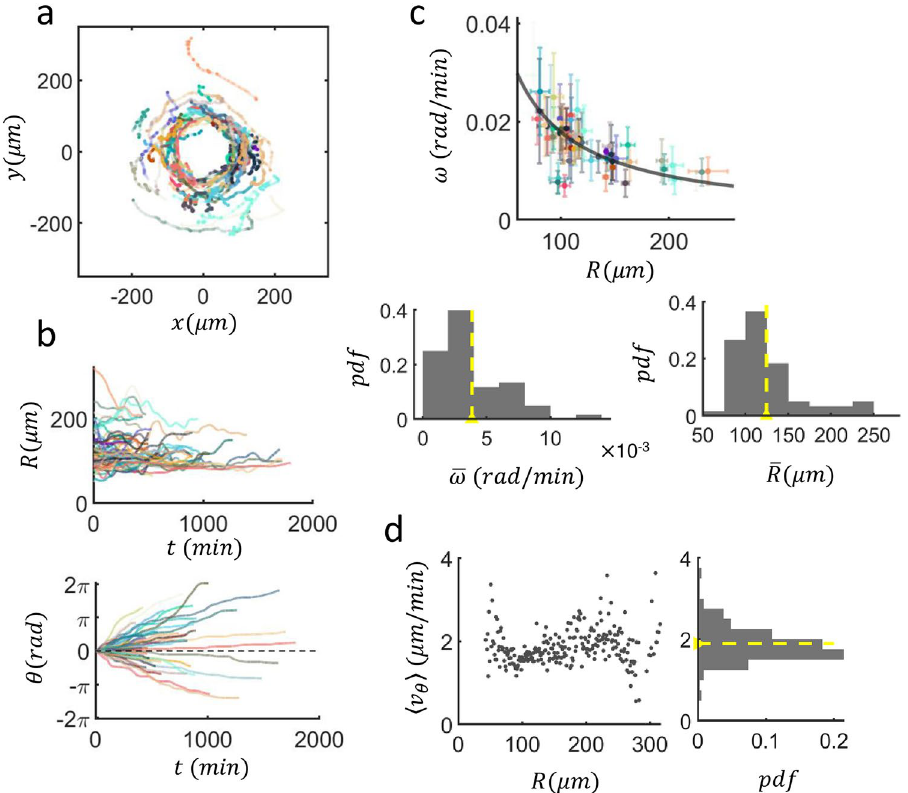
Figure 2. Analysis results showing heterogeneous motility of non-senescent cells and ω ’s functional dependence on R . ( a ) Trajectories of crawling MDA-MB-231 cells ( n = 60 different culture samples) in the reference frames of host senescent cells. ( b ) Distances between the normal cells and their corresponding host senescent cells (top) and unwrapped angular positions θ of normal cells with respect to the centers of the host senescent cells as a function of time (bottom) for n = 60 different pairs. All occasional abrupt reverse-turns are flipped to match the initial chirality (bottom). ( c ) (TOP) Angular speed ω ( �θ over (cid:31) t = 1 min) as a function of R for all n = 60 cells; colors match with trajectories in ( a ). Error bars represent the standard deviation, while 1.79 0.10 μm/min the mean value for each cell is represented by a dot. The solid line is a fit for A / R with A = ± (over 95% confidence level) (BOTTOM) Histograms of temporally averaged angular speeds ω (LEFT, mean value 3.9 × 10 –3 ± 2.6 × 10 –3 μm/rad) and the distances R (RIGHT, mean value 124.30 ± 40.46 μm) of all cells. The yellow dashed lines mark the mean of the time-averaged values. ( d ) Scatter plot of instantaneous tangential v θ v θ speed against R (left) and ’s histogram (right) (here, represents an average over all (cid:31) (cid:30) (cid:31) (cid:30) �· · · �